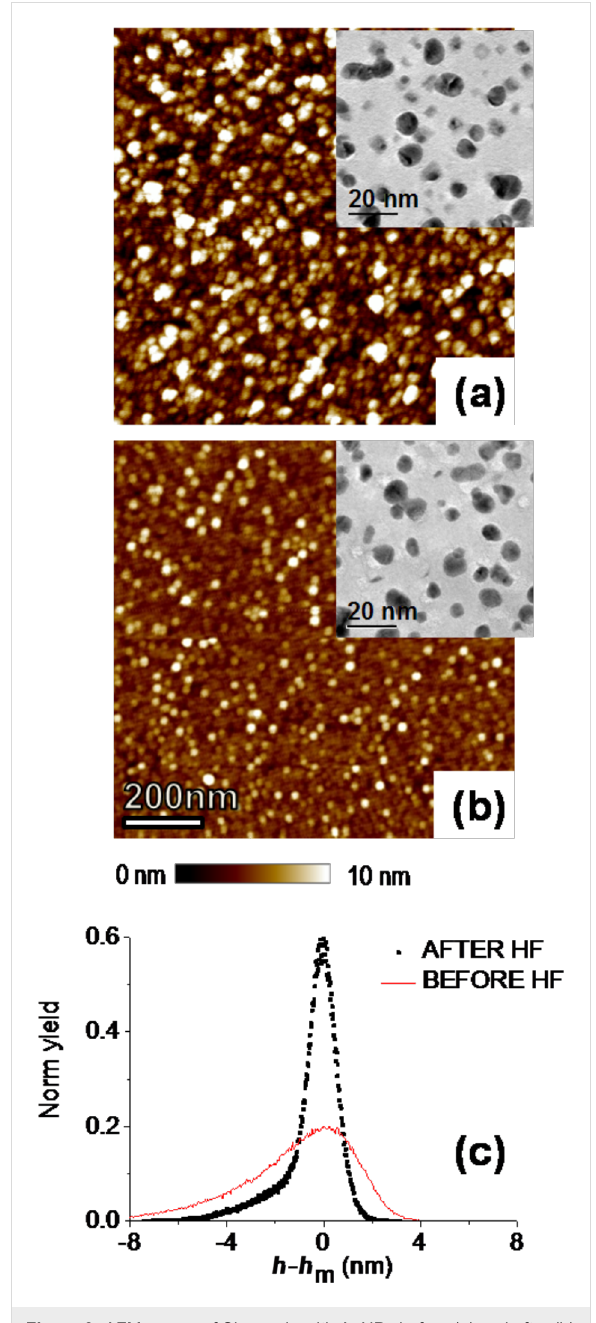
Figure 3: AFM z -scan of Si sample with AuNPs before (a) and after (b) a postdeposition bake in HF for 70 s, with the corresponding TEM images in the upper right hand part. (c) Height distribution relative to the mean value, as calculated from AFM